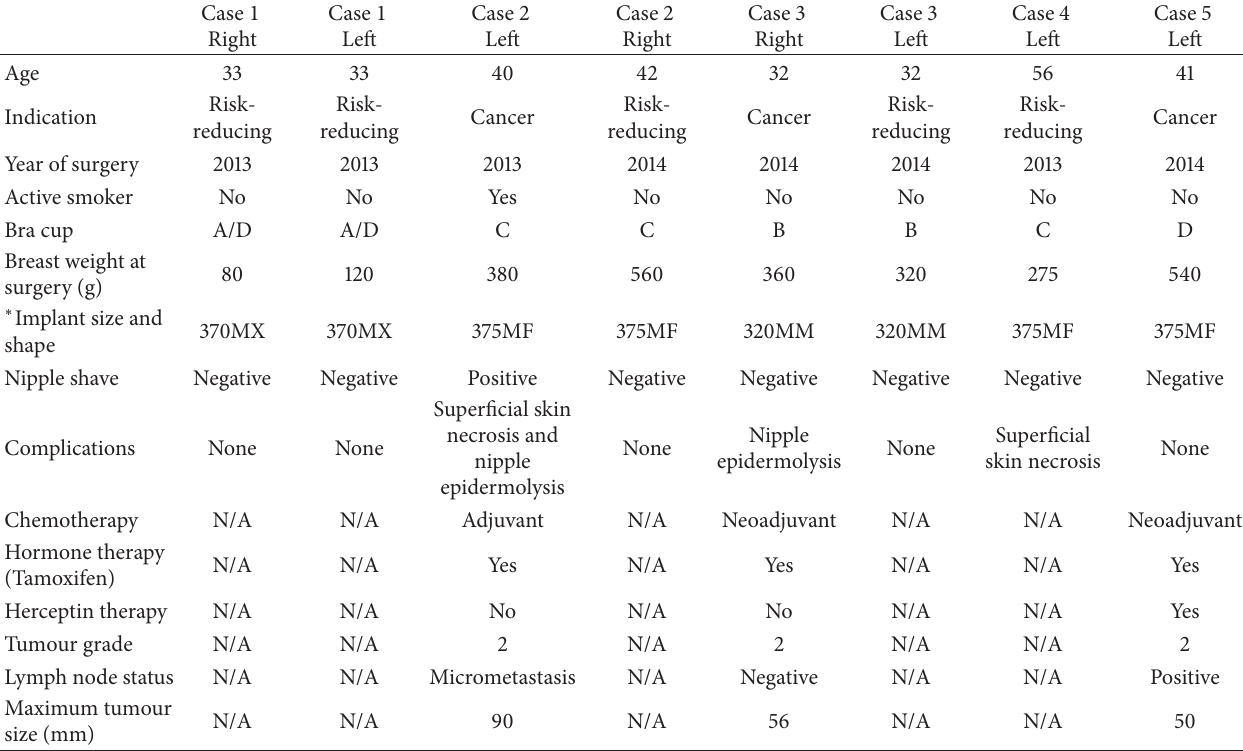
Table 1: Clinicopathological details of all the cases undergoing nipple sparing mastectomy with implant reconstruction using the modified dermal sling